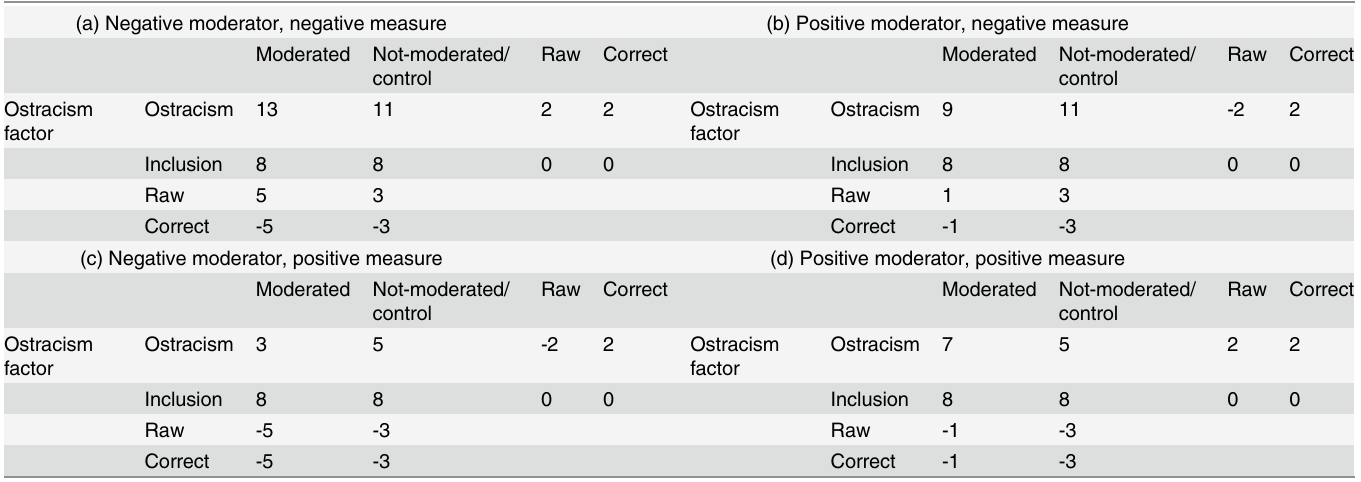
Table 1. Hypothetical data example of coding